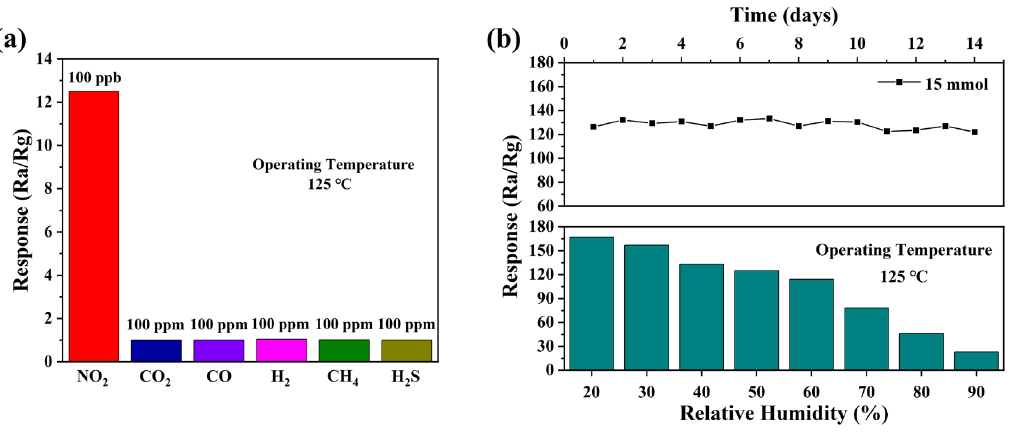
Figure 7. ( a ) The selectivity of sensor to 1 ppm NO 2 and 100 ppm other gases at different tempera- tures, ( b ) long-term stability of the sensor at 125 °C for 1 ppm NO 2 and response curve with relative humidity. Table 1. Comparison of this present work with reported ZnO − based NO 2 sensors.